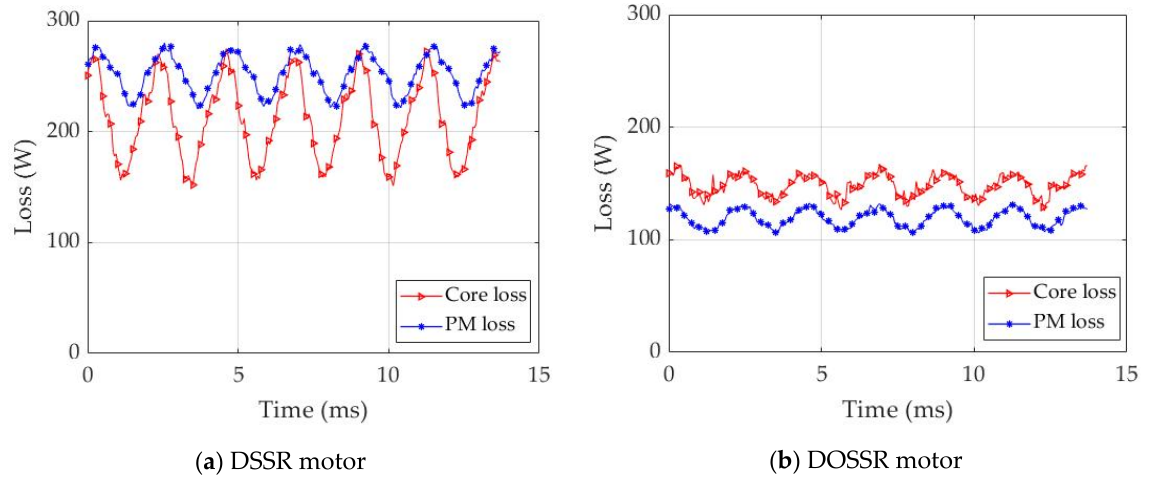
Figure 17. Comparison of core loss and PM loss for the DSSR motor with PM thickness of 4.5 mm and the DOSSR motor with PM thickness of 5 mm operating at peak torque at base speed (100 A rms, 900 rpm).